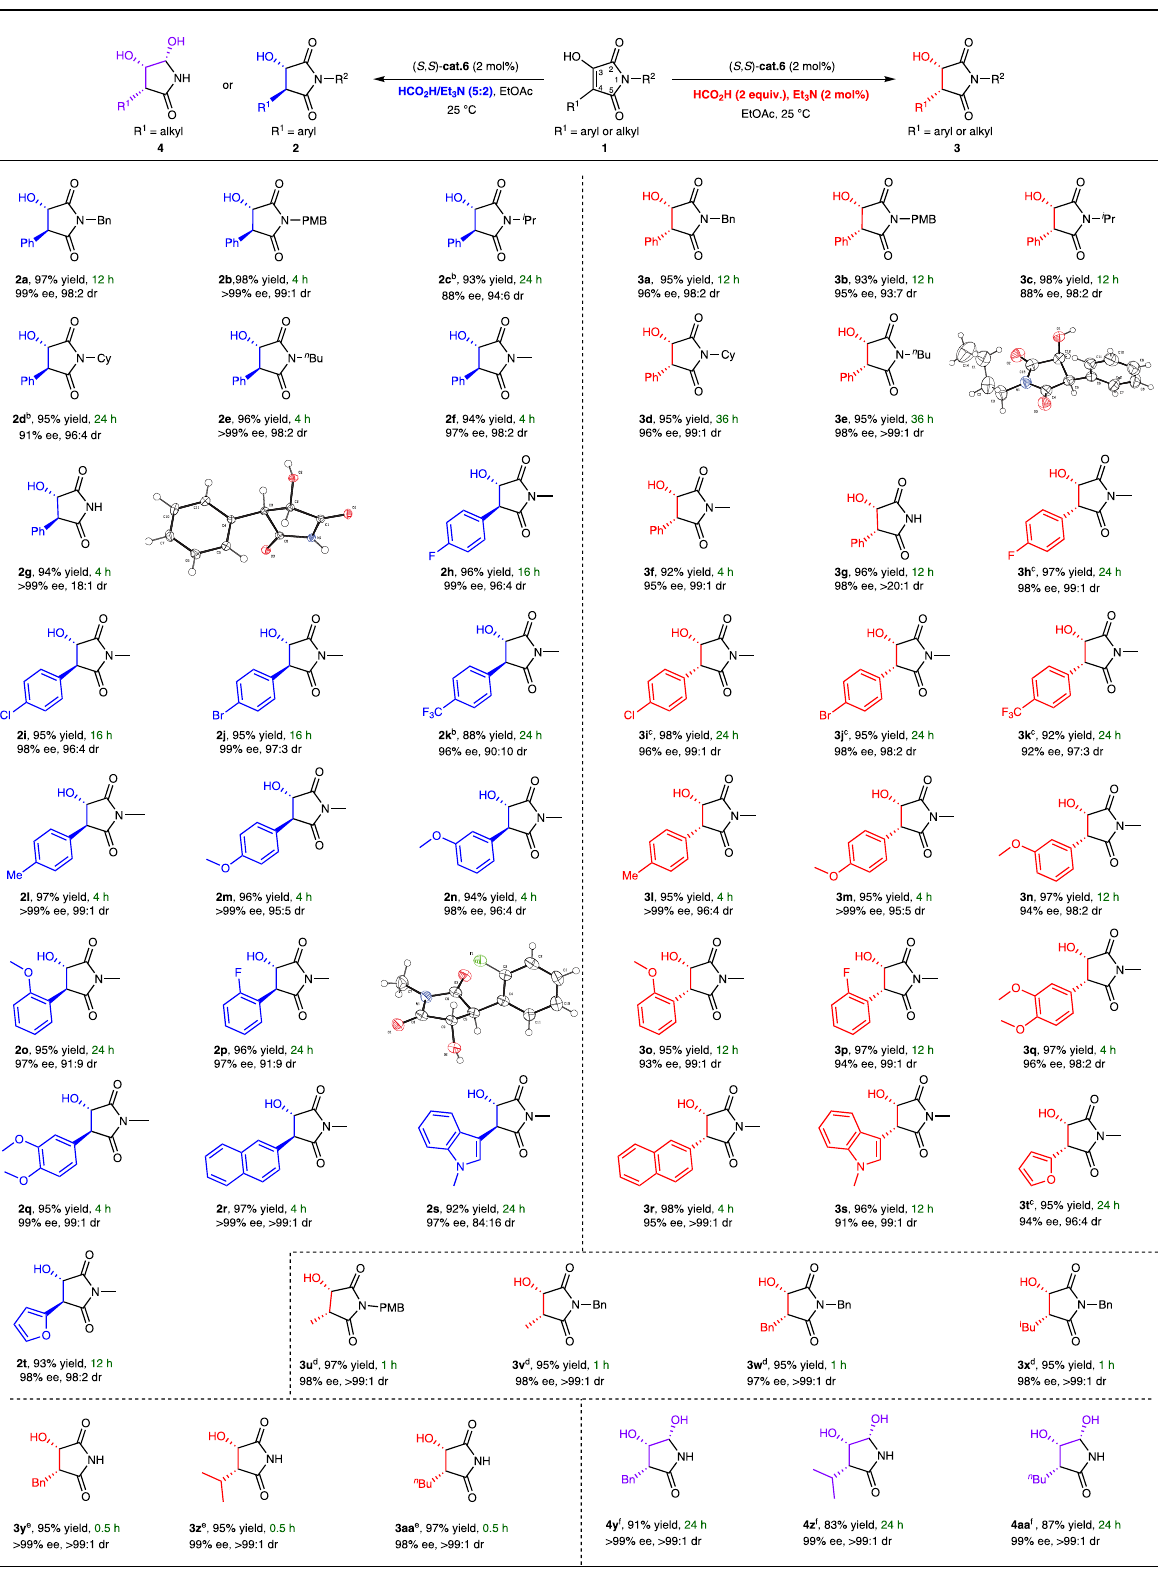
and HCO 2 H/Et 3 N azeotropic mixture (50 μ L) were used. c ( S , S )- cat.6 (5 mol%) and HCO 2 H (2.0 equiv.) were used for 24 h. d ( S , S )- cat.6 (1 mol%) and HCO 2 H/ Et 3 N azeotropic mixture (20 μ L) were used for 1 h. e ( S , S )- cat.6 (1 mol%) and HCO 2 H/Et 3 N azeotropic mixture (20 μ L) were used for 0.5 h. f ( S , S )- cat.6 (5 mol%) and HCO 2 H/Et 3 N azeotropic mixture (40 μ L) were used for 24